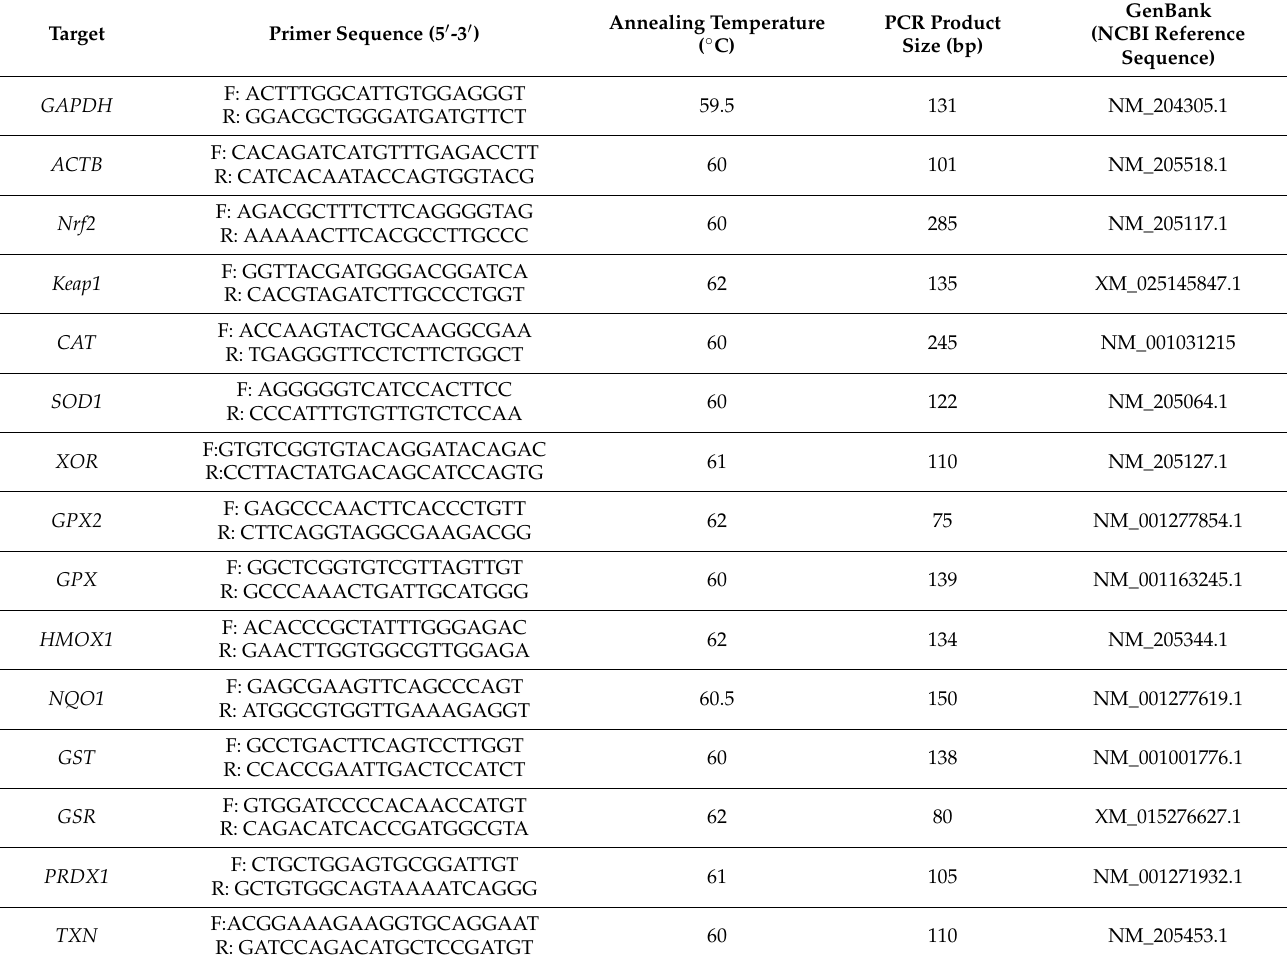
Table 1. Oligonucleotide primers used for gene expression of selected targets by quantitative real time PCR.